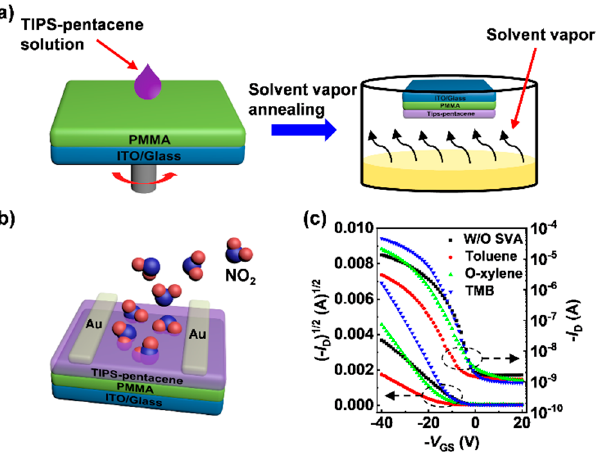
Figure 1. ( a ) Schematic illustrations of the SVA process for the TIPS-pentacene films. ( b ) The device architecture of the OTFT based NO 2 sensor. ( c ) Transfer curves ( V DS = − 40 V) for the pristine and SVA-treated OTFTs.